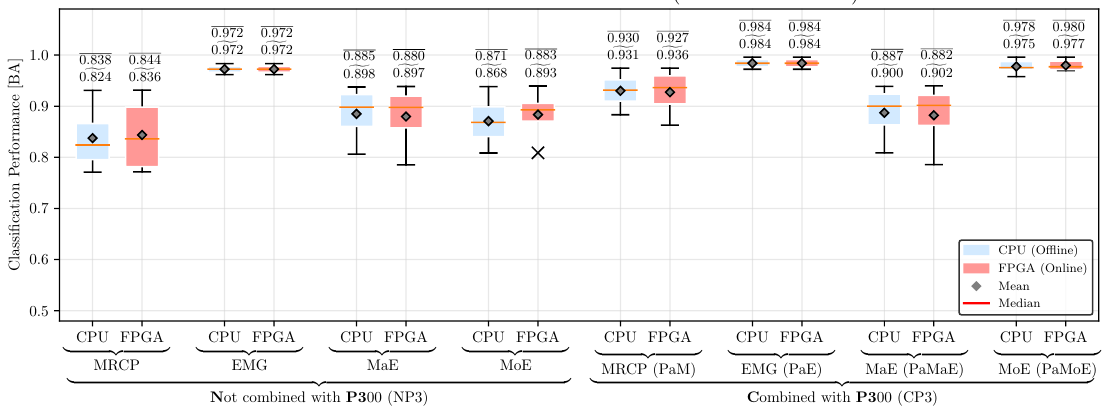
Figure 15. Classification Performance for Hybrid Movement Prediction for the Online Evaluation.